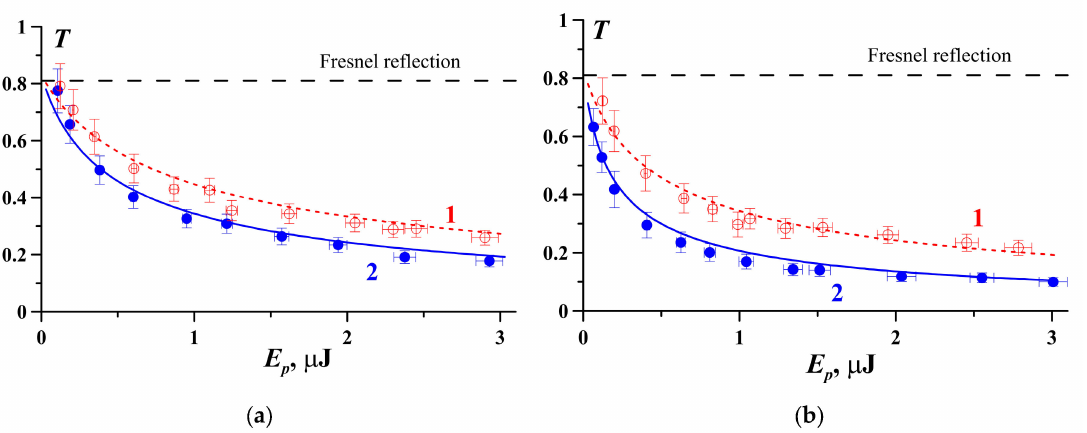
Figure 4. Dependences of the CSVO sample transmittance on the laser pulse energy for parallel ( a ) and perpendicular ( b ) orientation of the radiation polarization and the optical c-axis of the crystals; line 1: x = 0.3, line 2: x =